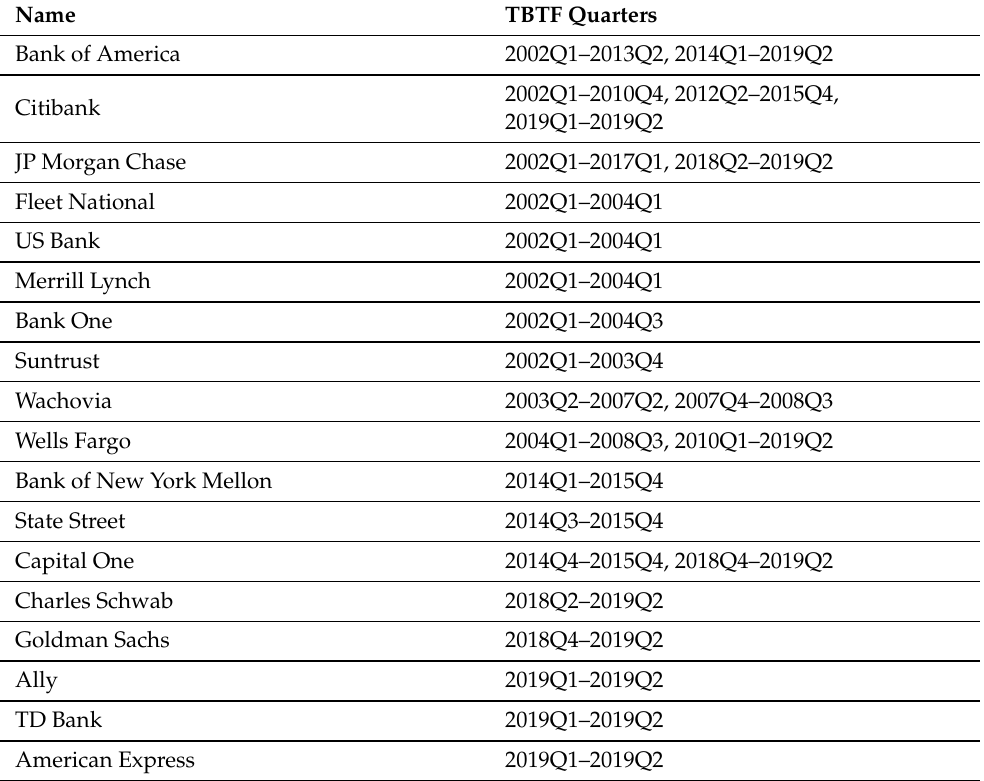
Table 3. List of TBTF Bank based on Bank Loss Portfolio Approach. This table reports TBTF banks from the first quarter of 2002 to the second quarter of 2019 based on the bank loss portfolio approach. TBTF banks are identified base on the loss betas constructed following the models in Section 2 using Call Reports. The sample contains 2821 quarterly observations from the first quarter of 2002 to the second quarter of 2019 with 67 unique commercial U.S.banks with assets over $50